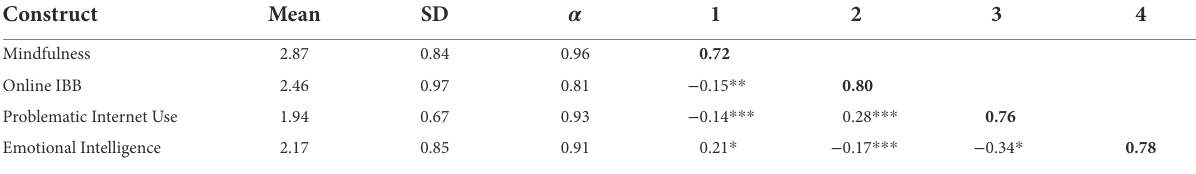
TABLE 3 Descriptive statistics, correlations and discriminant validity.